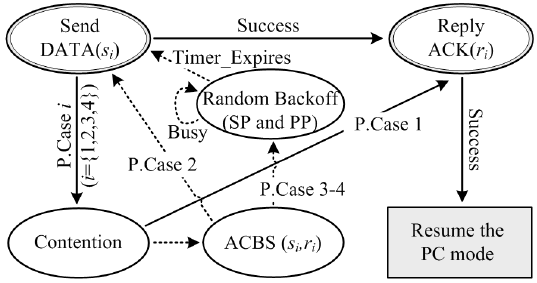
Figure 5. Schematic diagram of data transmission phase.